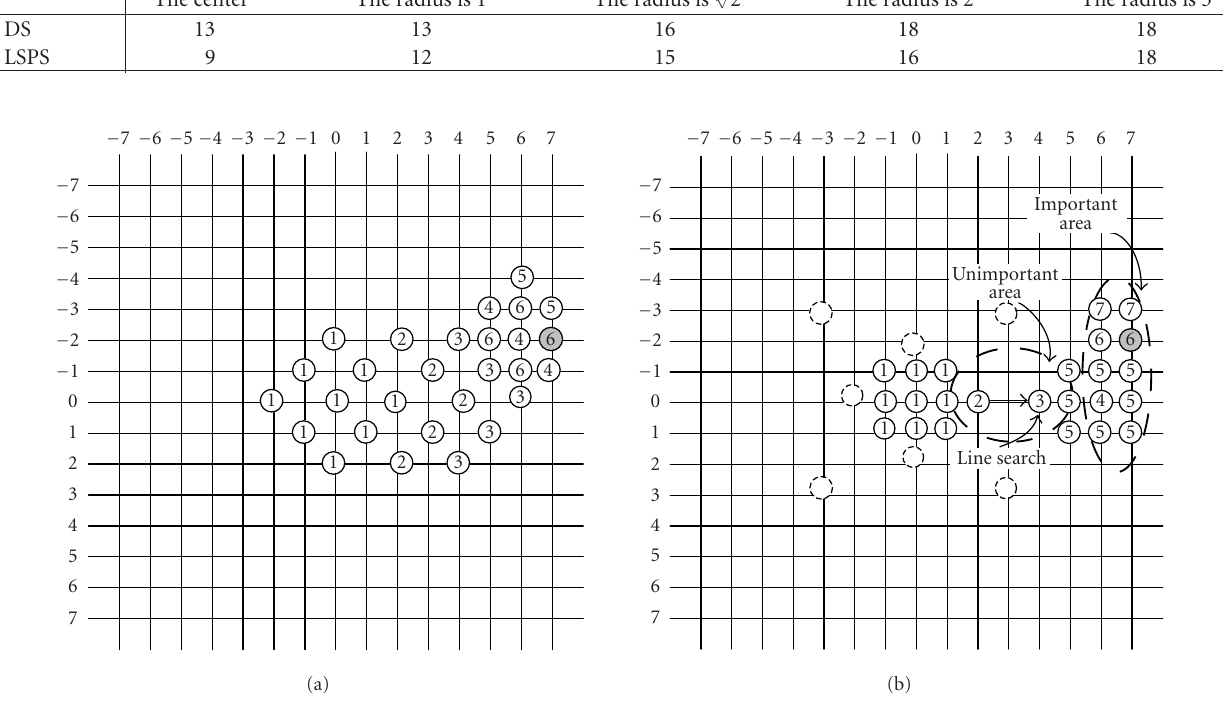
Table 1: Comparison between LSPS and DS in terms of the number of the search points for quasi-stationary block. The position of the best matching point Algorithm